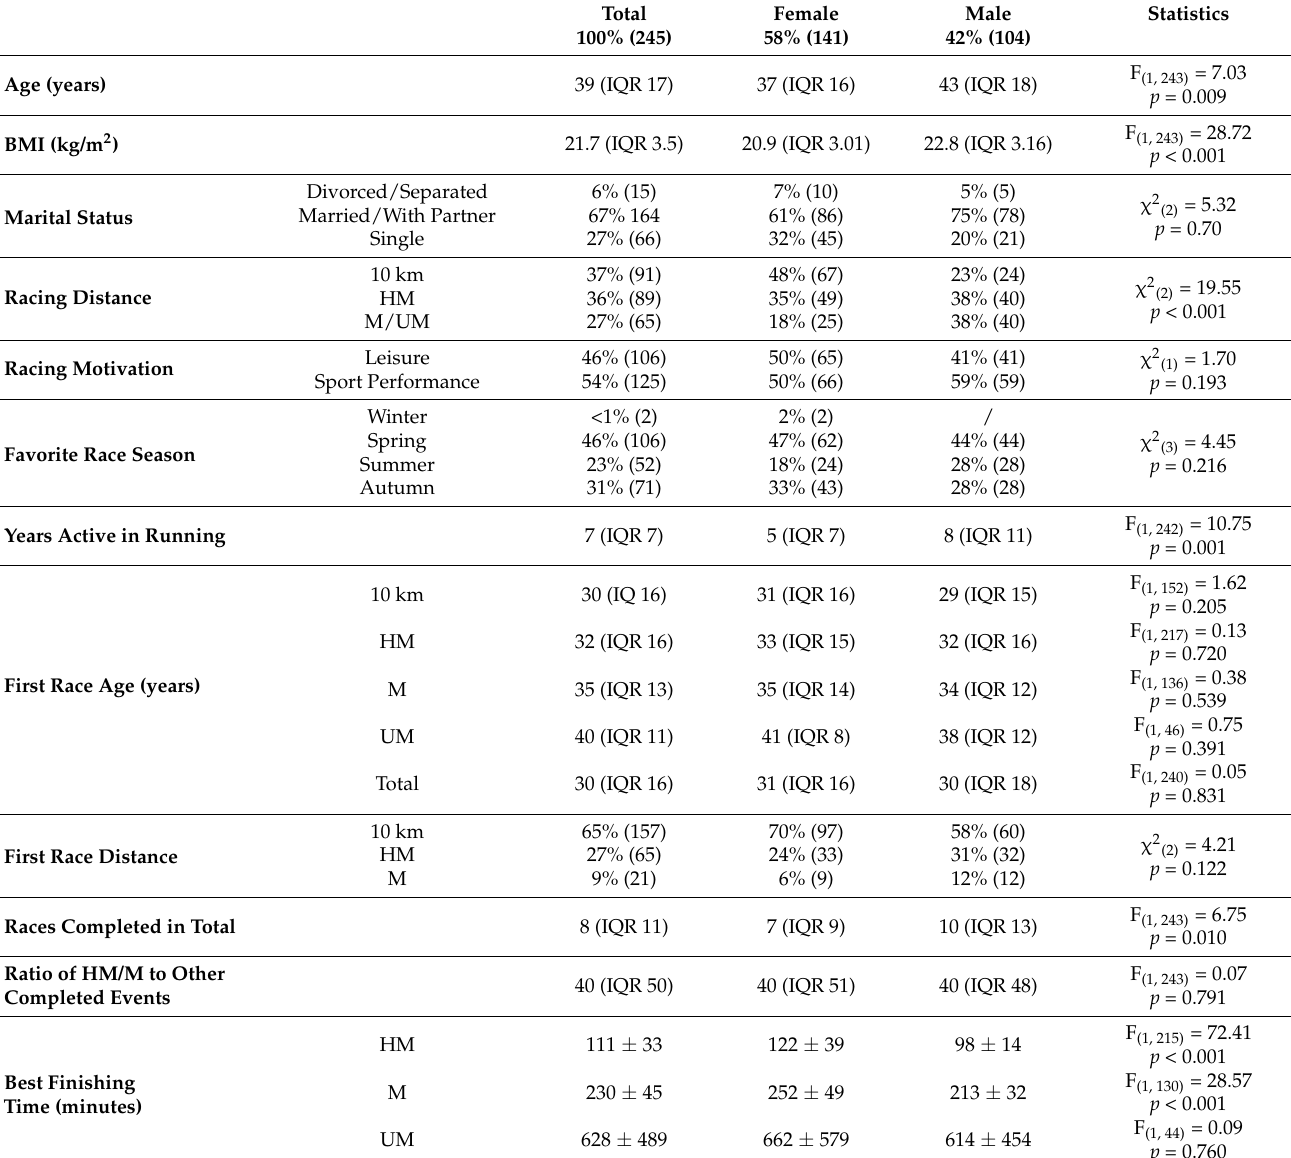
Table 1. Distance Runner Characteristics, including Racing Motivation, Preferences, and Experience Displayed by Sex. Total Female Male Statistics 100%